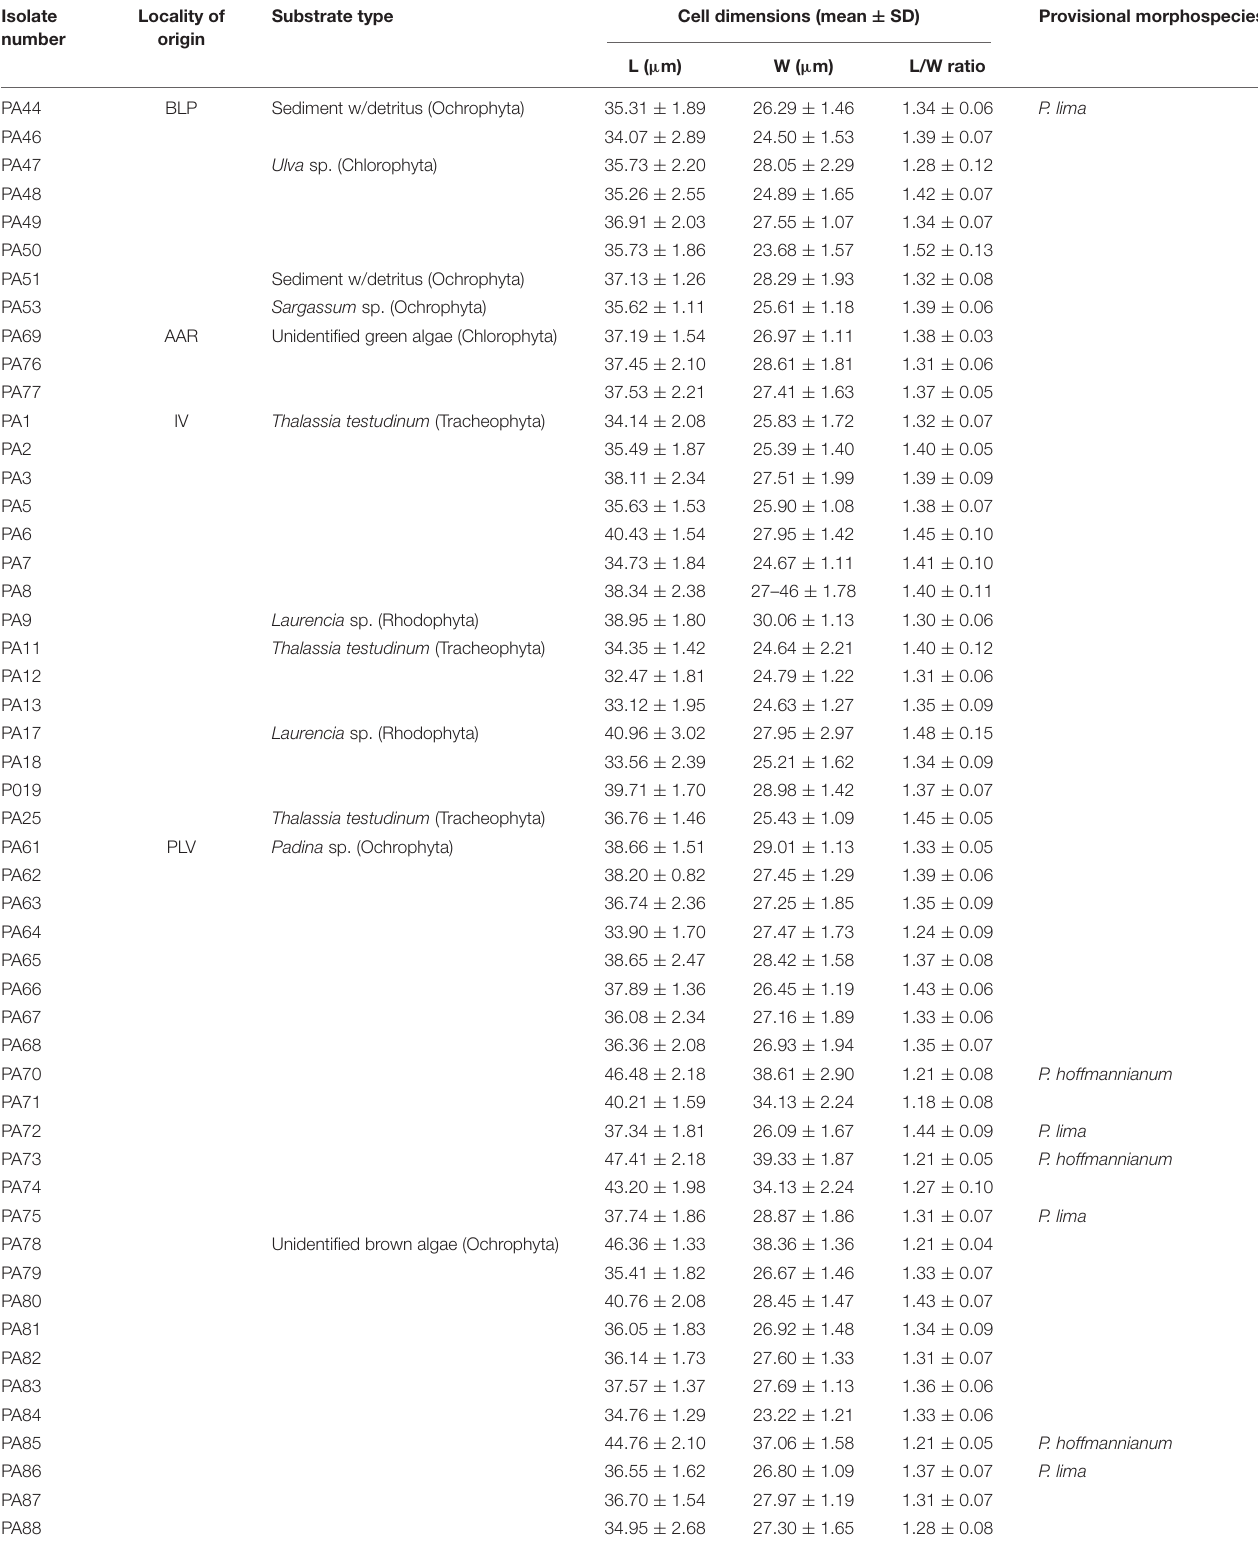
TABLE 1 | Cultured clonal isolates ( n = 69) of Prorocentrum species from locations on the Gulf of California, Gulf of Mexico, and Caribbean coasts, indicating locality of origin and substrate type, and provisional species assignment according to morphological characteristics. Isolate Locality of number